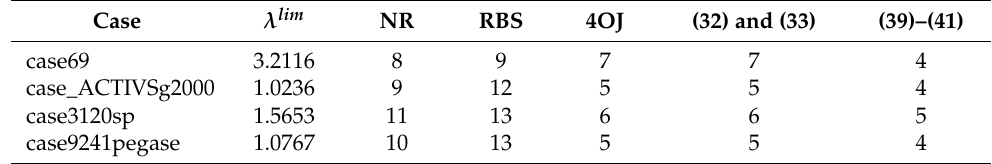
Table 3. Total iterations for well-conditioned cases with limit load